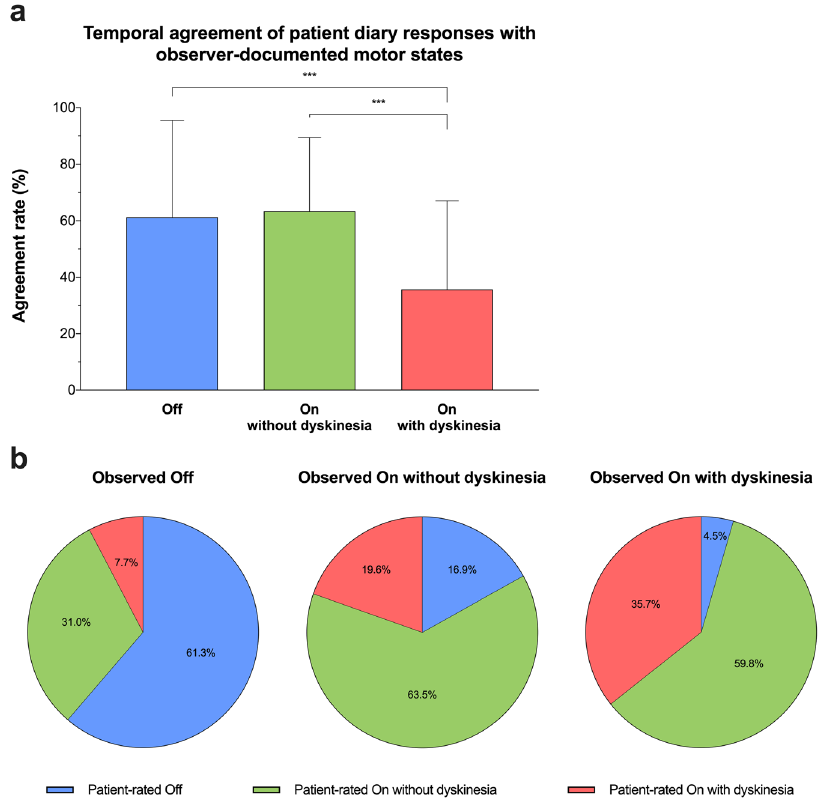
Fig. 2 Temporal agreement of patient diary responses with observer-documented motor states and preferred patient choices in the respective motor states. a The mean agreement rate for Off (blue colour), On without dyskinesia (green colour) and On with dyskinesia (red colour) based on 1997 simultaneous half-hourly diary ratings of 51 patients with Parkinson ’ s disease and an independent clinical observer serving as reference for the comparison. b Illustrates preferred choices on the patient diary in the respective motor states. Values provided as means + standard deviation ( a ) and proportions in % ( b ). *** P < 0.001 from Kruskal – Wallis test with Dunn – Bonferroni post-hoc tests, corrected for multiple